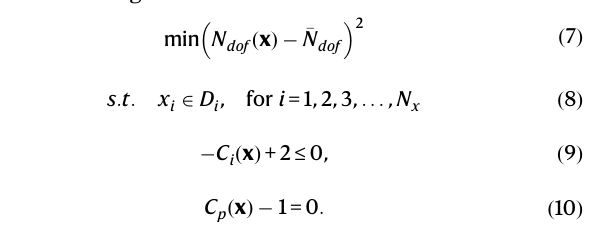
(cid:1) N dof , we formulate a search